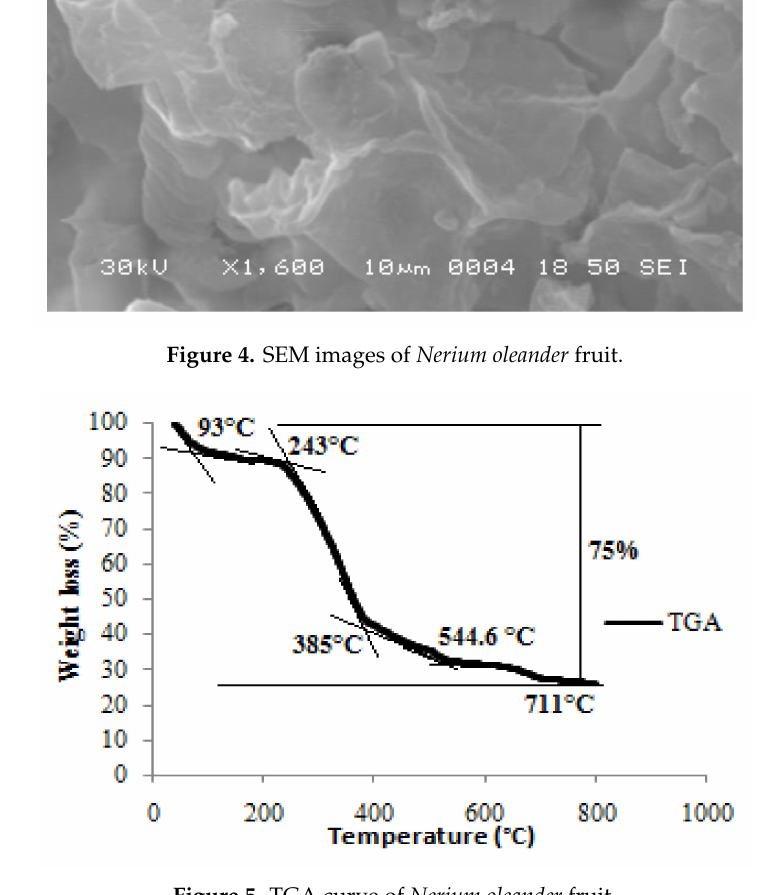
Figure 5. TGA curve of Nerium oleander